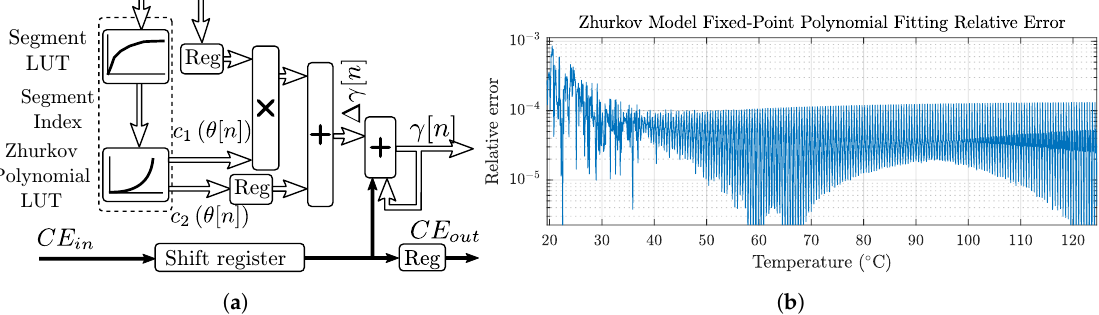
Figure 11. Mutual and soil thermal step responses: ( a ) pipelined Zhurkov model architecture implementation; and ( b ) relative error of the polynomial fitting of the Zhurkov Model.